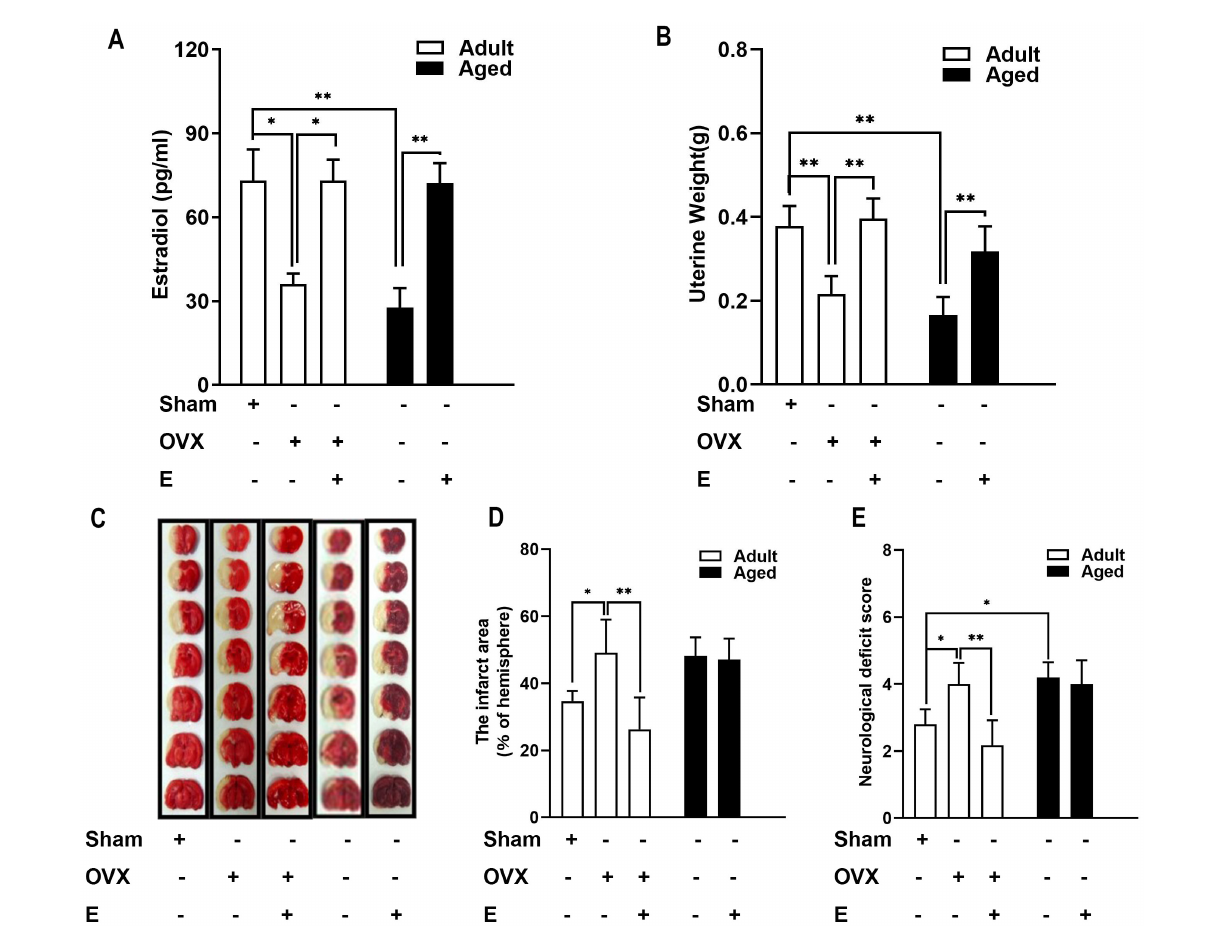
FIGURE 1 Estrogen conferred neuroprotection in adult OVX rats but not in aged rats. (A) In adult rats, OVX led to a decrease in serum estrogen levels, whereas estrogen supplements (500 μ g/kg, daily subcutaneous injections) for 28 days recovered the hormonal level. In aged rats, the serum estrogen level is very low, and the administration of estrogen reversed the hypo-estrogen condition. (B) Elevated uterine weight was exhibited after the administration of estrogen in adult OVX and aged rats. (C–E) In adult rats, estrogen deficiency induced by OVX led to a substantial enlargement in MCAO-induced infarction volume and neurological deficits compared with the sham group. This effect of OVX was significantly prevented by supplementation with estrogen. Ischemic damage was more severe than in aged rats than in adult rats, and estrogen supplements did not confer neuroprotection. C shows representative rostrocaudal series of TTC-stained coronal sections 1 day after MCAO. Data were analyzed by the one-way analysis of variance (ANOVA) followed by least significant difference t -test, n = 5–6 in each group. * p < 0.05, ** p <